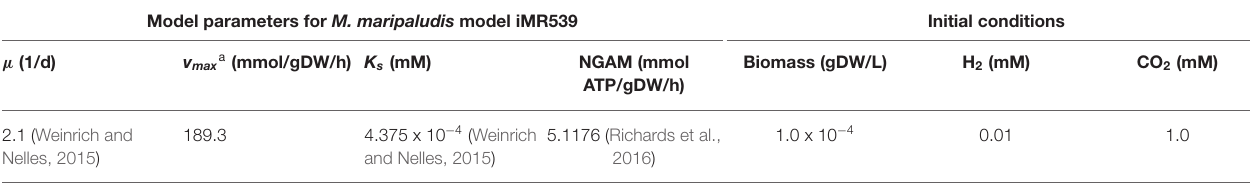
TABLE 1 | Model parameters and initial conditions for mono culture simulation. Model parameters for M. maripaludis model